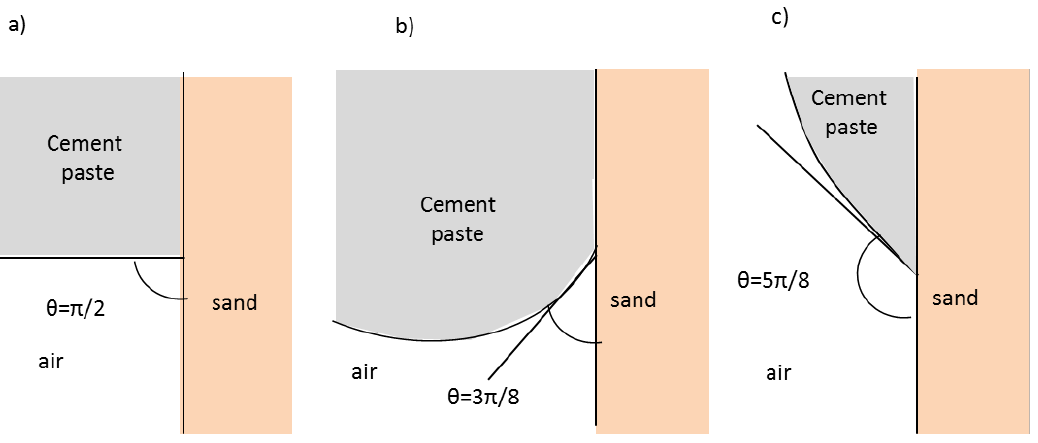
Figure 5. Contact angle at the interface cement-air-sand: ( a ) θ = π / 2; ( b ) θ = 3 π / 8; ( c ) θ = 5 π /